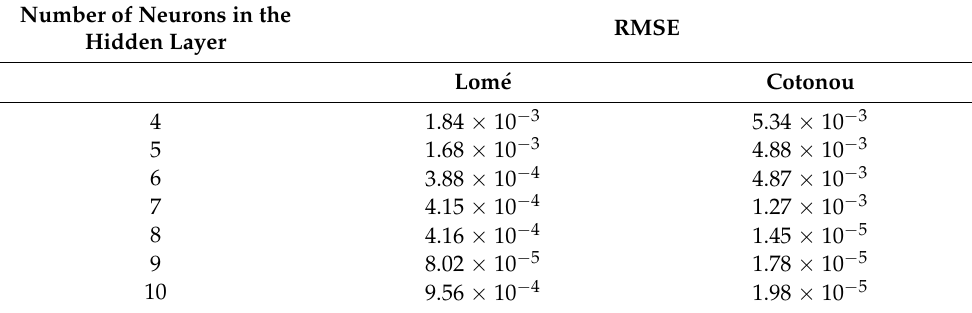
Table 5. Choice of the number of neurons.